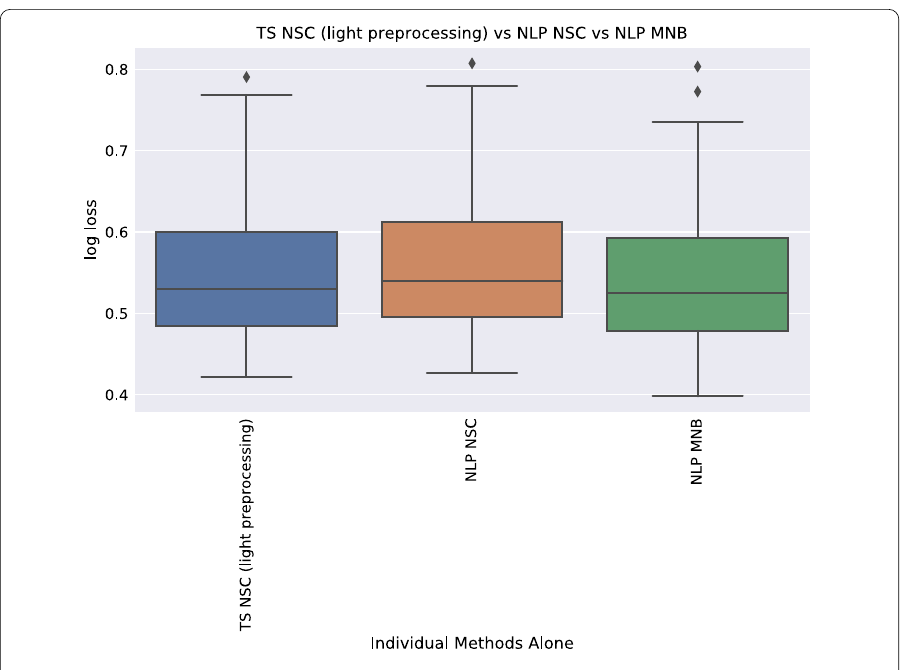
Figure 21 Distributions of the test log loss scores obtained from Time Series Method (TS NSC light preprocessing), NLP NSC method and NLP MNB method alone